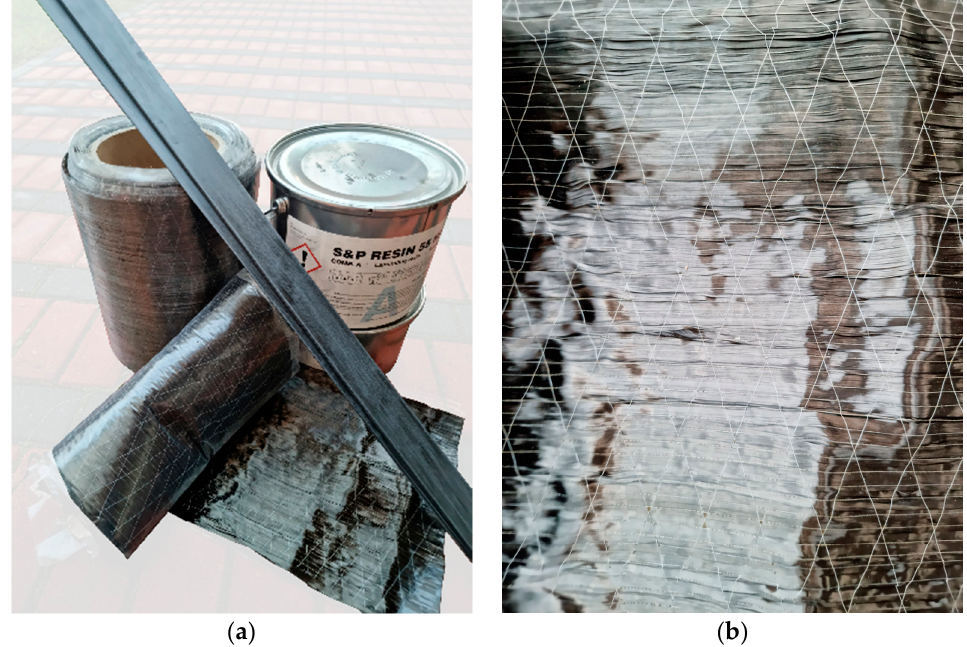
Figure 3. Strengthening system: ( a ) components of composite reinforcement; ( b ) CFRP sheet.